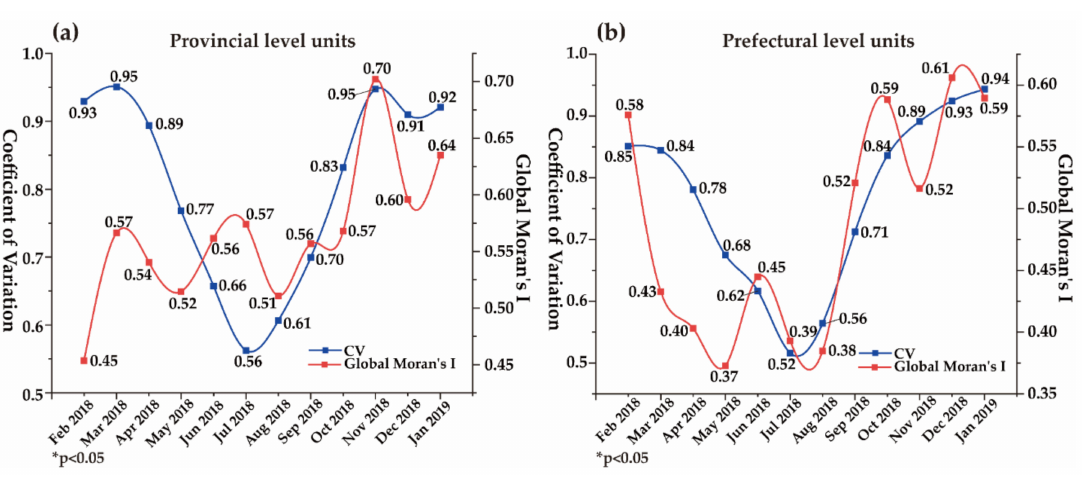
Figure 5. The monthly Coe ffi cient of Variation (CV) and Global Moran’s I at provincial and prefectural units. (Note: ( a ) shows the CV and Global Moran’s I under the Provincial level unit; ( b ) shows the CV and Global Moran’s I under the Prefectural level